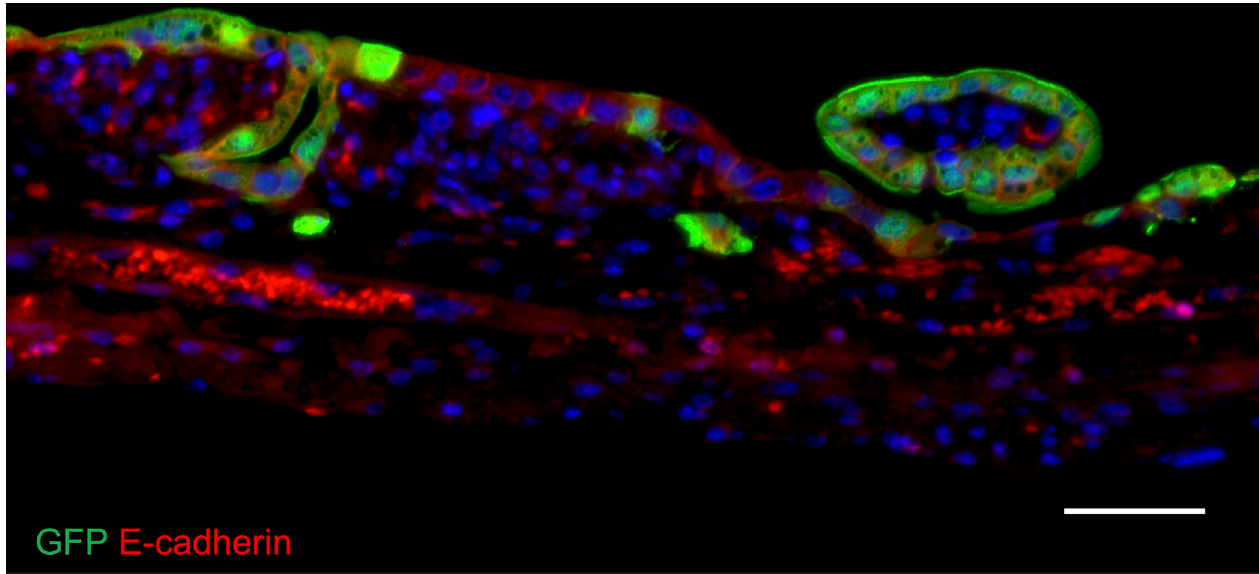
Fig 4. Immunofluorescence stain of engrafted GFP human enteroids in NSG mouse small intestine one week after implantation with anti-E-cadherin antibodies. Nuclei are counter-stained with DAPI. Scale bar, 50 μ m.